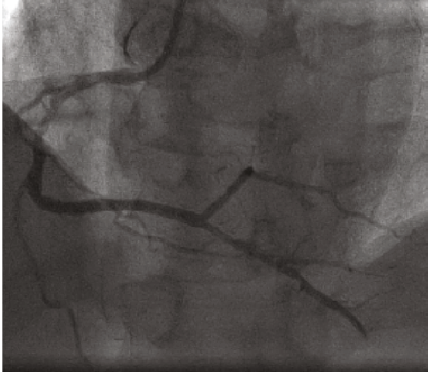
Figure 6: Recanalized right coronary artery (RCA)